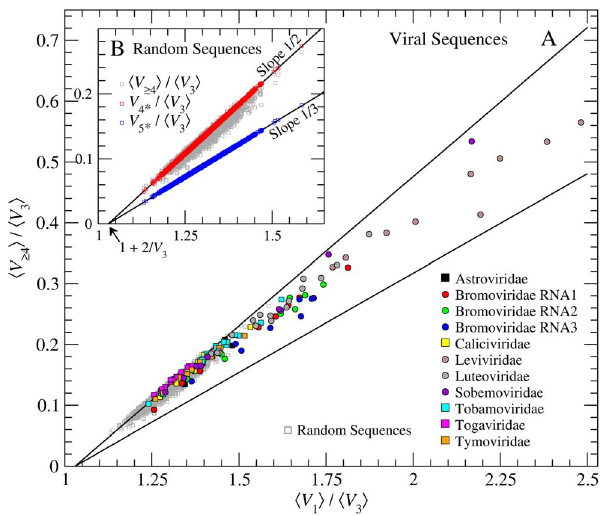
Figure 3. Higher-order branching in random and viral RNAs. S V § 4 T = S V 3 T is shown versus S V 1 T = S V 3 T in both plots. Inset B shows 4000-nt random-sequence data (gray squares) with V 4 (cid:3) = S V 3 T (red squares) and V 5 (cid:3) = S V 3 T (blue squares) plotted against S V 1 T = S V 3 T (see Eqs. 4 & 5). Values of S V § 4 T / S V 3 T (gray squares) are consistent with V 4 (cid:3) = S V 3 T , indicating that most higher-order junctions in random RNAs have d ~ 4 . Plot A compares the random sequences with eleven distinct families of viral RNA. Families with more than half their members having S V 1 T = S V 3 T § 1 : 48 are shown with circular symbols.